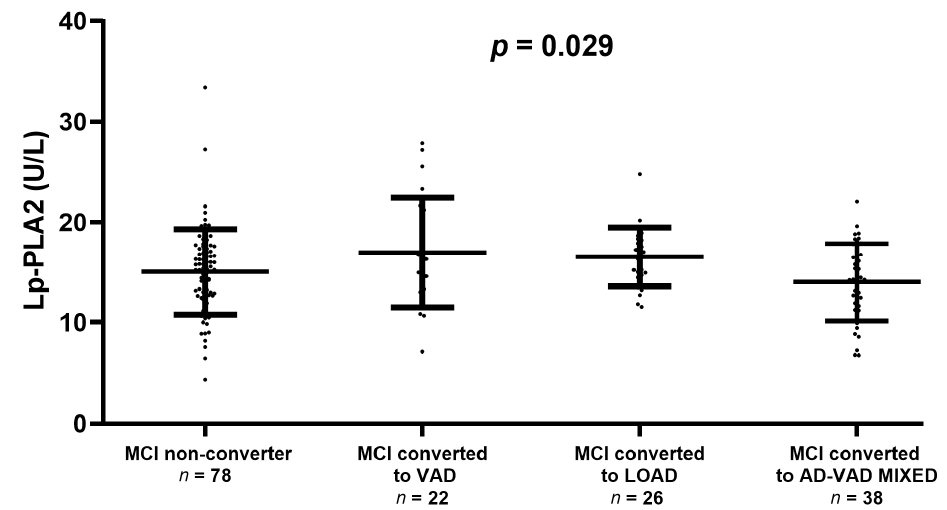
Figure 2. Serum Lp-PLA2 activity levels in Mild Cognitive Impairment (MCI) that remains stable (MCI non-converter) or converting to Vascular Dementia (VAD), Late-Onset Alzheimer’s Disease (LOAD), or AD-VAD MIXED. The plot does not display the levels of Lp-PLA2 in MCI converted to other dementia subtypes because of the very low number of subjects ( n = 2). Comparison between groups was performed by ANOVA which yielded p = 0.029.